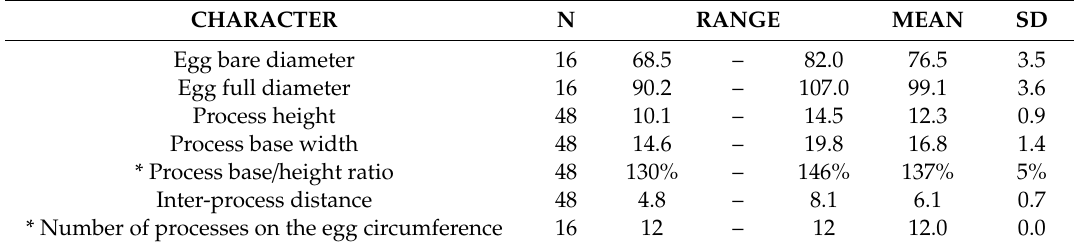
Table 4. Measurements [in µ m] of selected morphological structures of eggs of the Antarctic population of Paramacrobiotus fairbanksi Schill, Förster, Dandekar & Wolf [25] mounted in Hoyer’s medium (N–number of eggs / structures measured, RANGE refers to the smallest and the largest structure among all measured eggs; SD–standard deviation). * except of values of ratio which is presented as percentage and number of processes on the egg circumference which is as number.